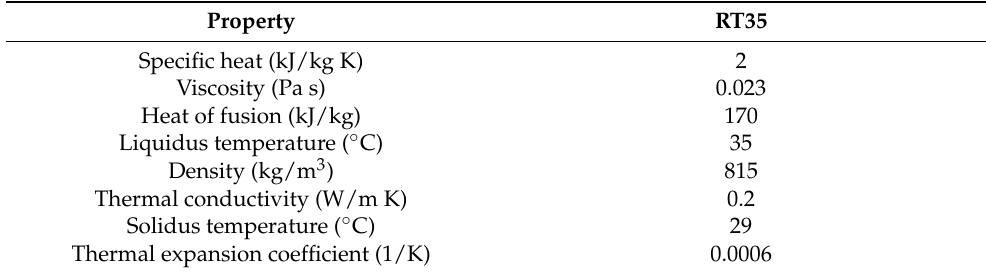
Table 1. Thermo-physical properties of RT35